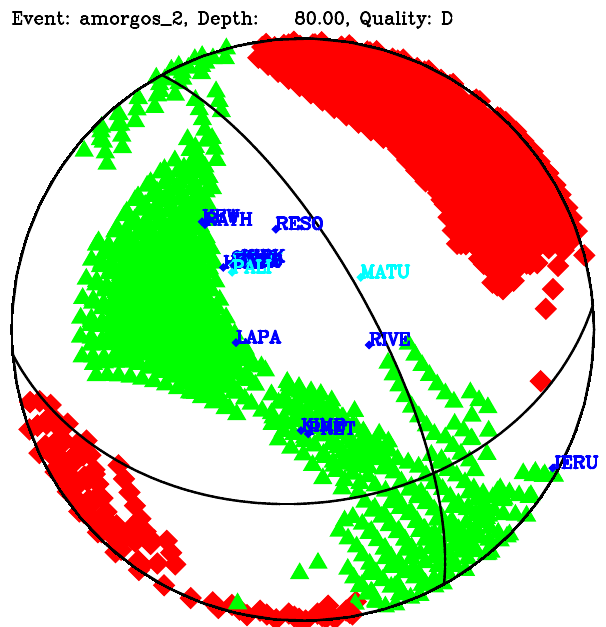
Figure 17. Compatible fault plane solutions obtained with the HASH method for first-motion polarities of the second Amorgos event taken from the ISS bulletin. Blue and turquoise dots with sta- tion names indicate positive and negative polarity, respectively. Red squares mark the piercing points of the P axes and green triangles indicate piercing points of the T axes. The nodal lines represent the average fault plane solution calculated by